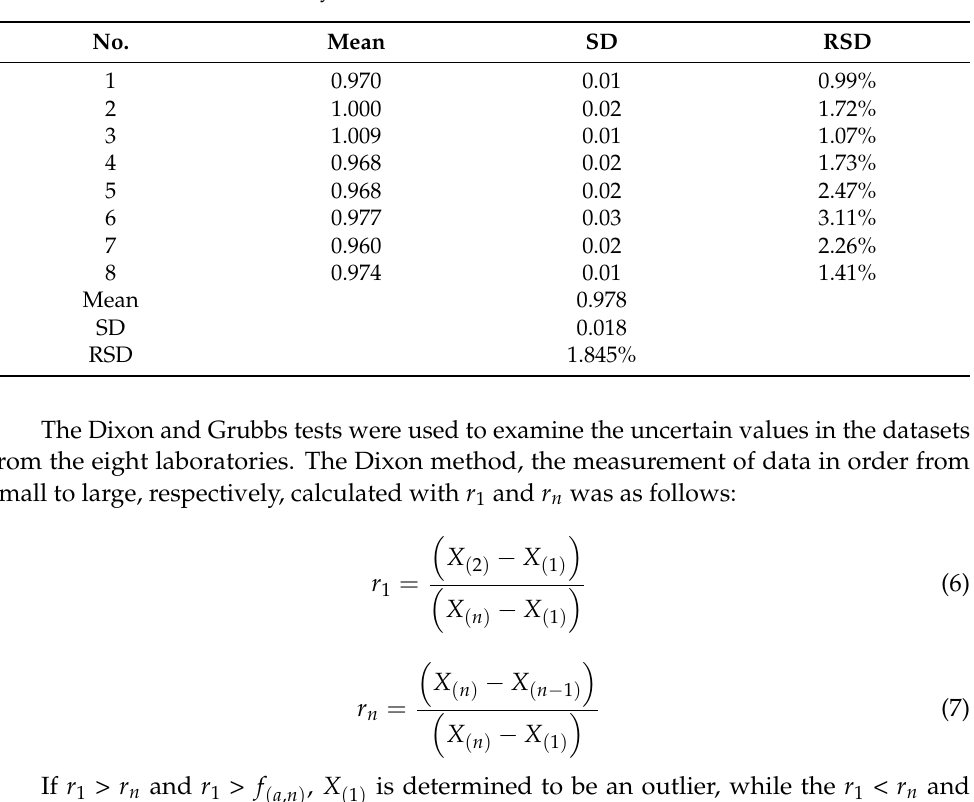
Table 4. Results of inter-laboratory